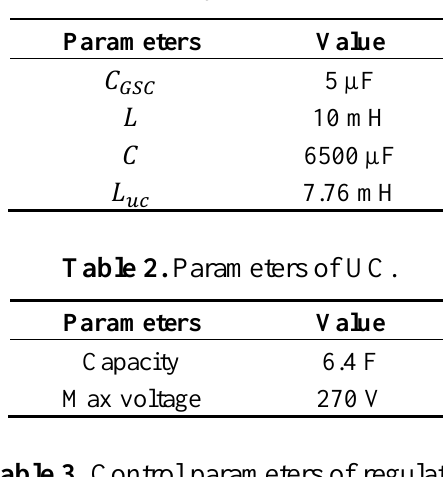
Table 1. Parameters of system circuit in the Figure 1.